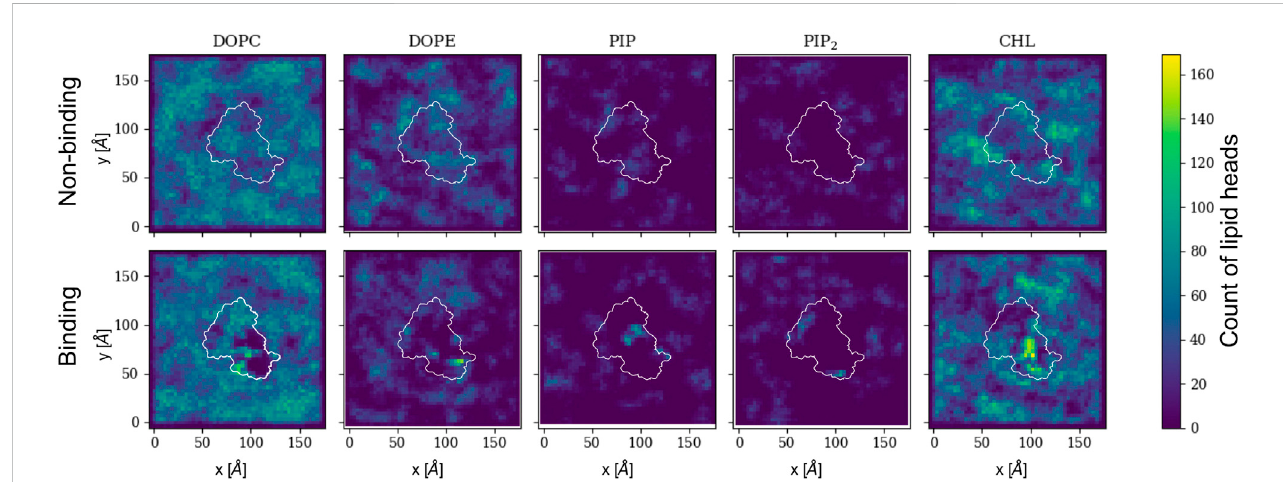
FIGURE 5 2Dcumulativehistogramsforthelast500nsofRep3trajectory.Toprowcorrespondstoobservationsfornon-bindinglea fl et,andthebottomrowforthe binding lea fl et. White contours show a representative projection of the protein and the color bar is the cumulative number of lipids in each square of the 2D histogram, represented by either their P atom or O3 for cholesterol. Color intensity changes from dark blue to bright yellow as concentration of lipid head atoms